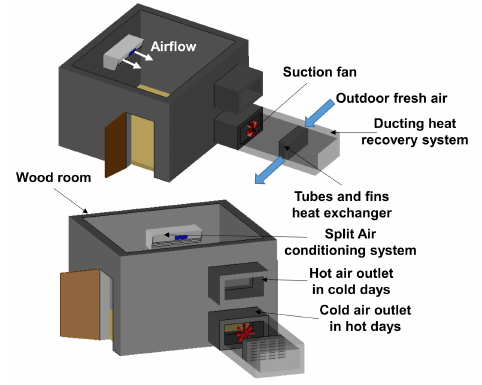
Figure 2. Schematic of the experimental